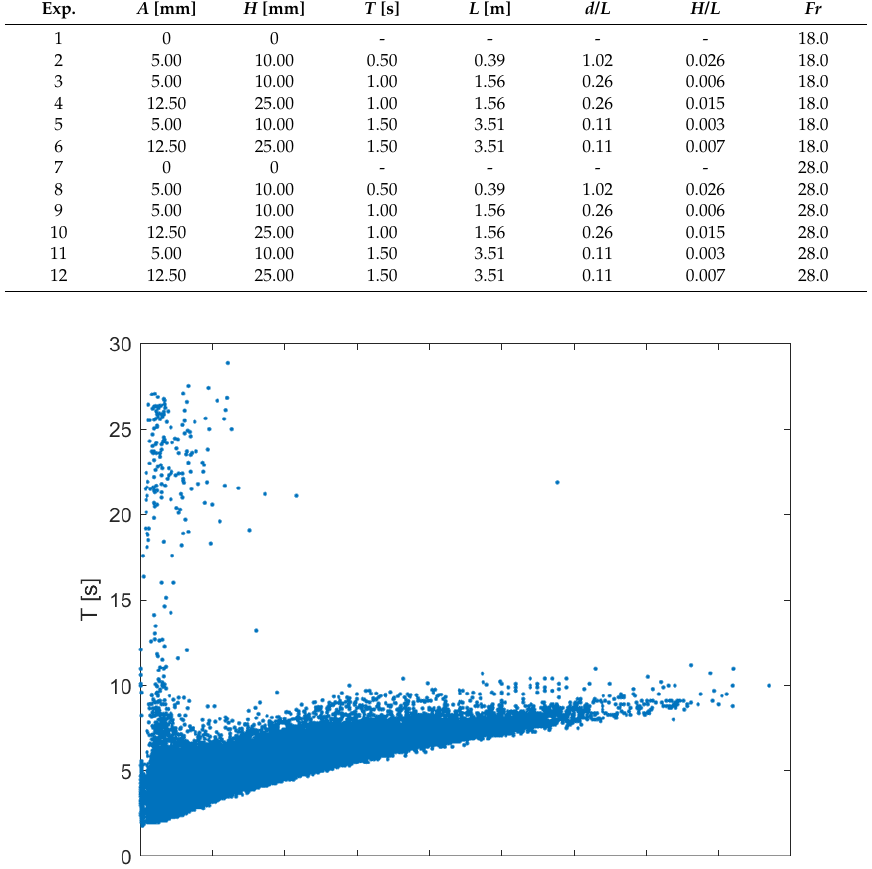
Table 1. Main parameters for the experiments; A is the wave amplitude, H the wave height, T the wave period, L the wave length, d the water depth (0.40 m), Fr the densimetric Froude number; experiments 1 and 7 were performed without waves as reference cases. Exp.